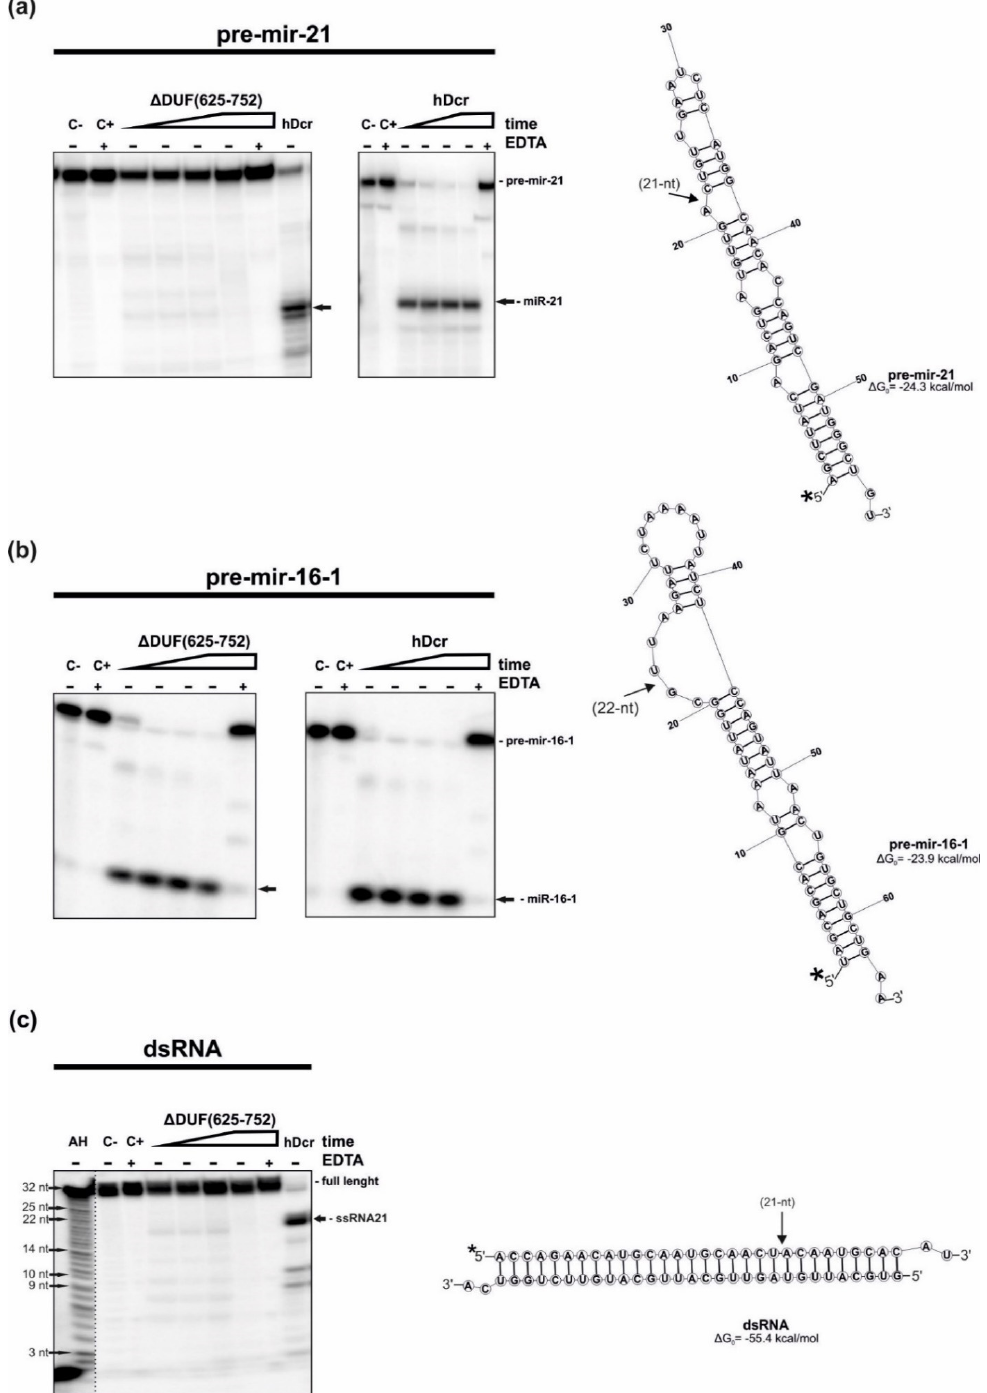
Figure 2. RNase activity assay of hDcr and Δ DUF(625-752). ( a – c ) The results of the RNA-cleavage assays involving: ( a ) pre-mir-21, ( b ) pre-mir-16-1, ( c ) 30-bp dsRNA with 2-nt 3 ′ -overhangs. Reaction mixtures were incubated for: 10, 30, 60, 120 min (increasing time is represented by a triangle) with 18 nM of either ∆ DUF(625-752) or hDcr. (C-) controls containing only the substrate in the reaction buffer. (C+) controls incubated without a protein but with 25 mM EDTA. (+EDTA) supplementation of the reaction buffer with 25 mM EDTA. (AH) Ladder generated by alkaline hydrolysis of 5 (cid:48) - 32 P-labeled 21-nt RNA. Dicer cleavage sites are indicated by arrows. * The asterisk indicates the 32 P 5 (cid:48) -end label. The reproducible results were obtained using at least two batches of recombinant ∆ DUF(625-752) and